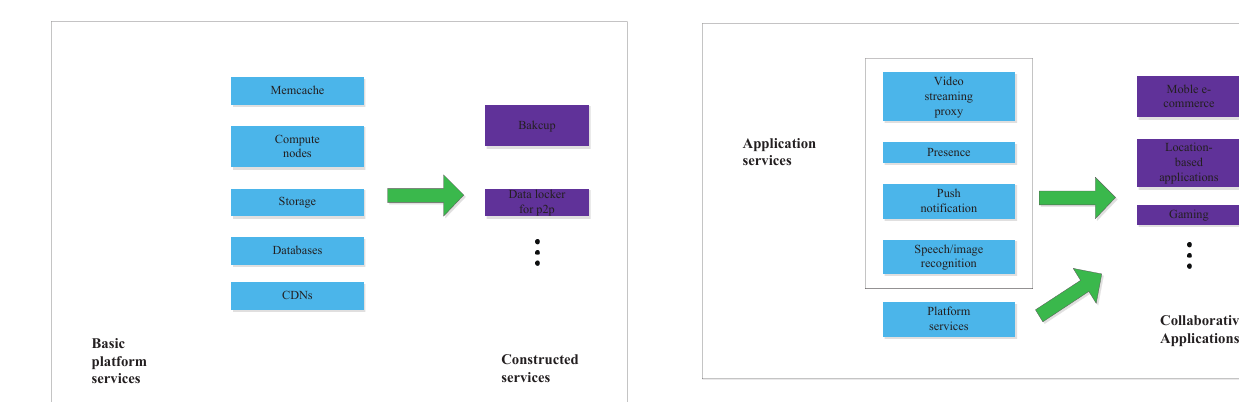
Figure 4. Application